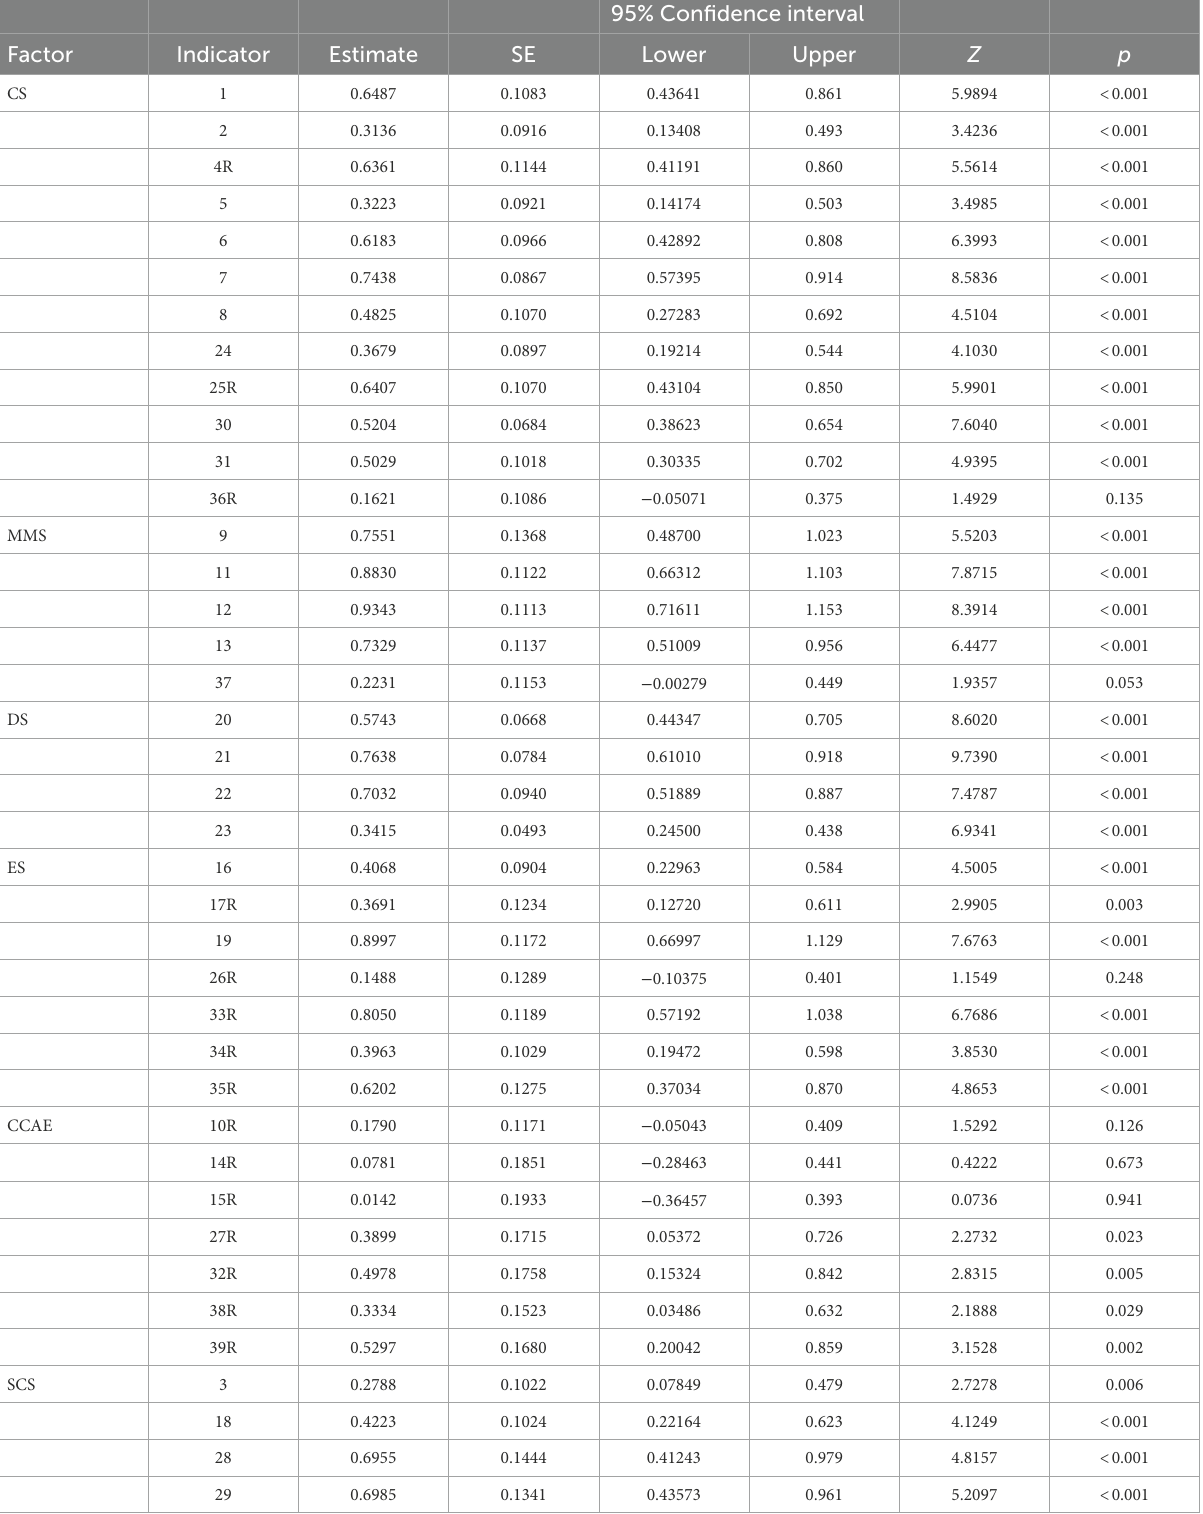
TABLE 2 Confirmatory factor analysis factor loadings